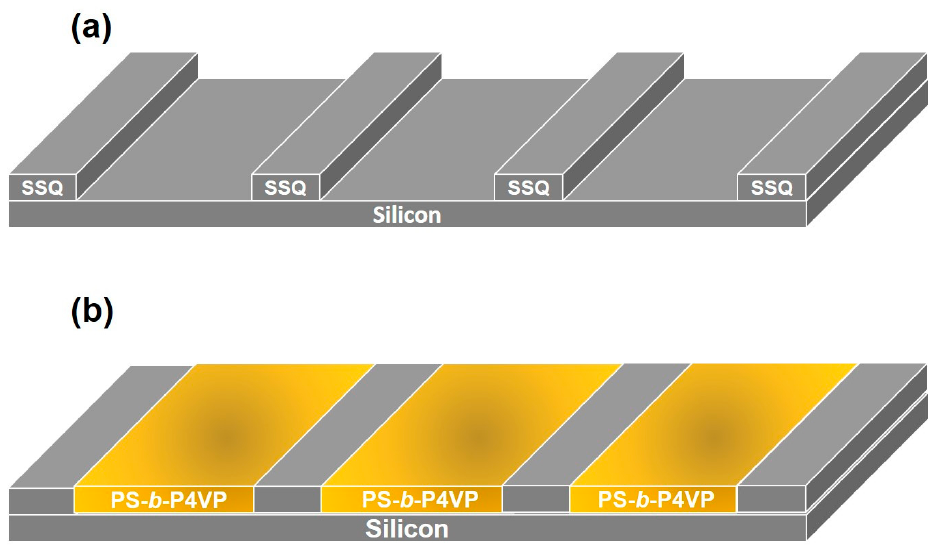
Figure 1. ( a ) SEM image of tungsten trioxide nanowires from PS-b-P4VP line template and tungsten chloride ethanolic precursor post UV/O 3. Scale bars correspond to 500 nm (main image) and 100 nm (inset), respectively. Corresponding XPS analysis of nanowires showing ( b ) survey spectrum, ( c ) W 4f high-resolution core scan, and ( d ) O 1s high-resolution core